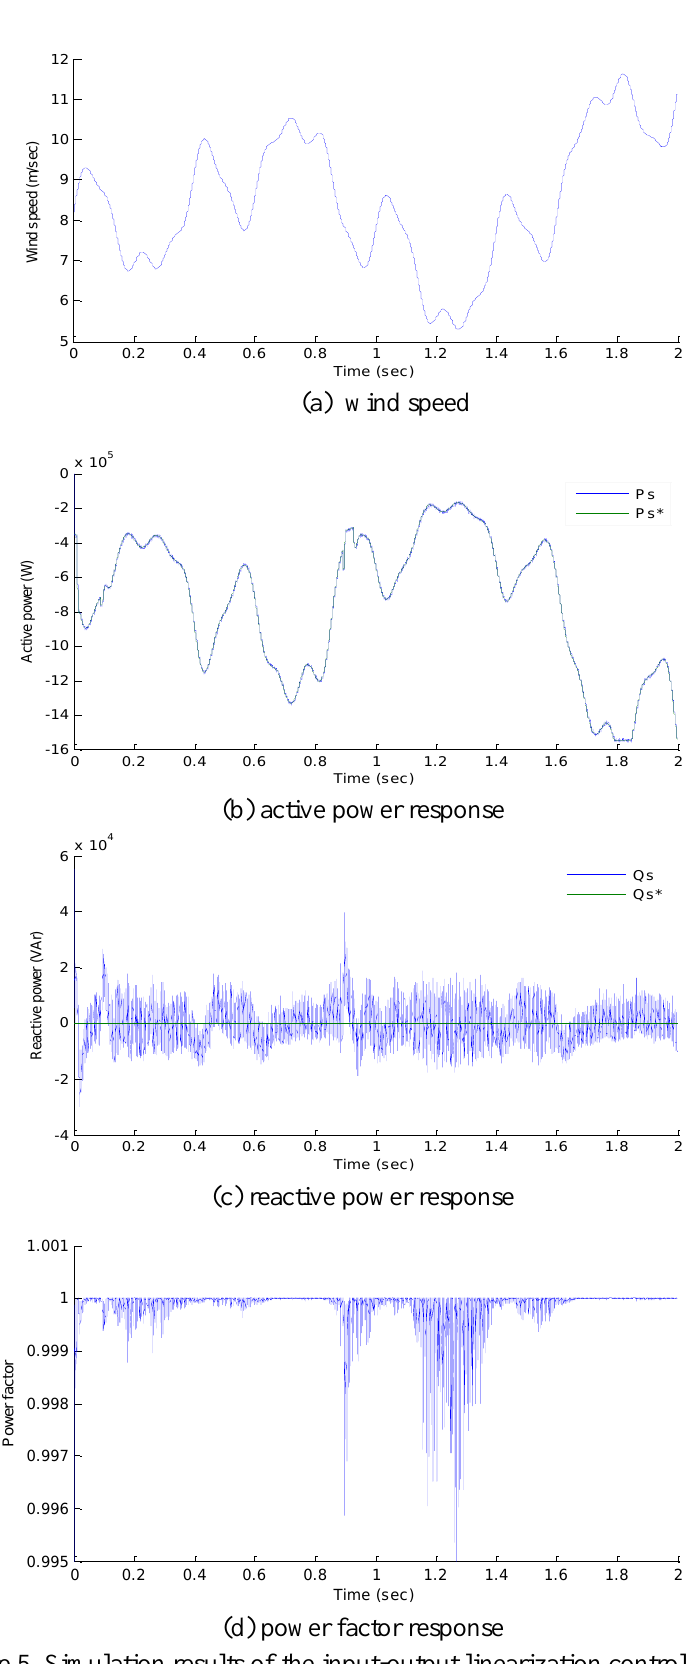
Figure 5. Simulation results of the input-output linearization control of DFIG Fig. 5.b shows a very fast response of the active power, where it follows perfectly its reference generated by the MPPT strategy with a negligible error. The reactive power is maintained at its reference equal to zero